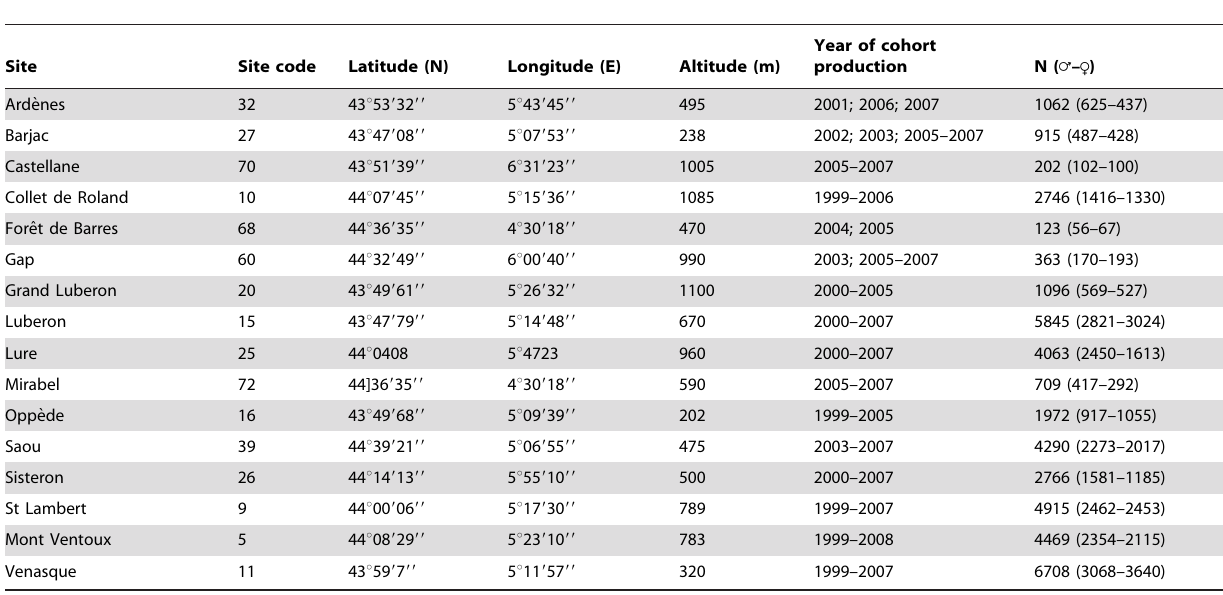
Table 1. Sample information including the sampled localities, site codes and coordinates for a total of 97 cohorts of M. schimitscheki in southern